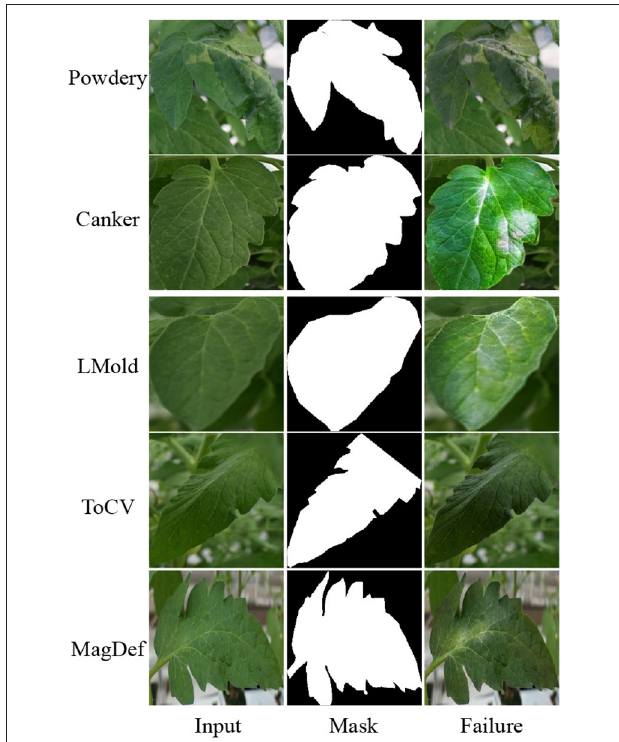
FIGURE 6 | Some translation failure examples from our